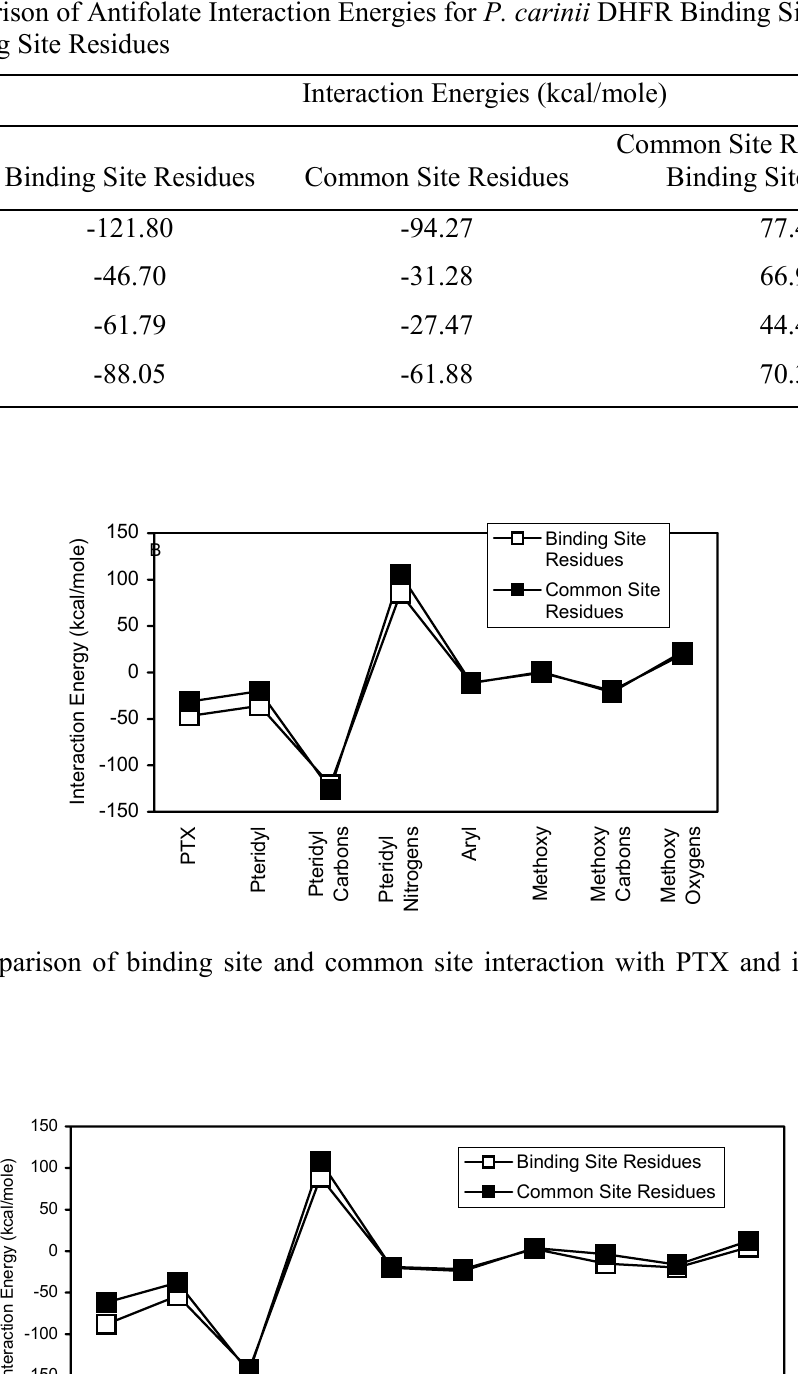
Table 2. Comparison of Antifolate Interaction Energies for P. carinii DHFR Binding Site and